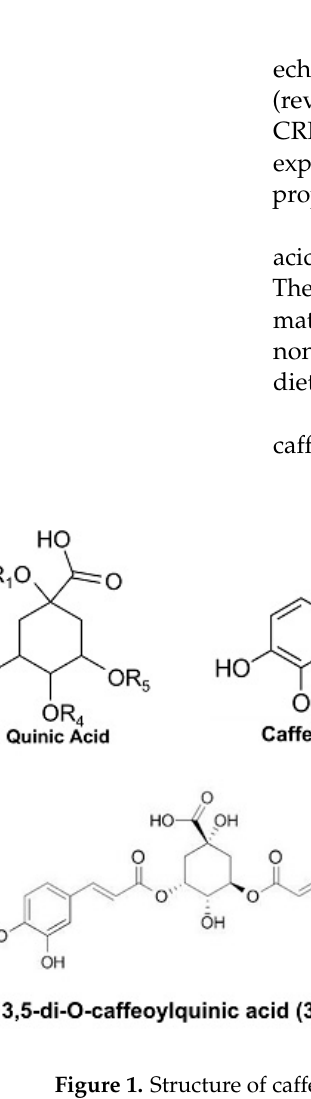
Figure 1. Structure of caffeoylquinic and dicaffeoylquinic acid isomers (IUPAC numbering). CA= caffeic acid. In comparison with mono-caffeoylquinic acids, of which chlorogenic acid is the